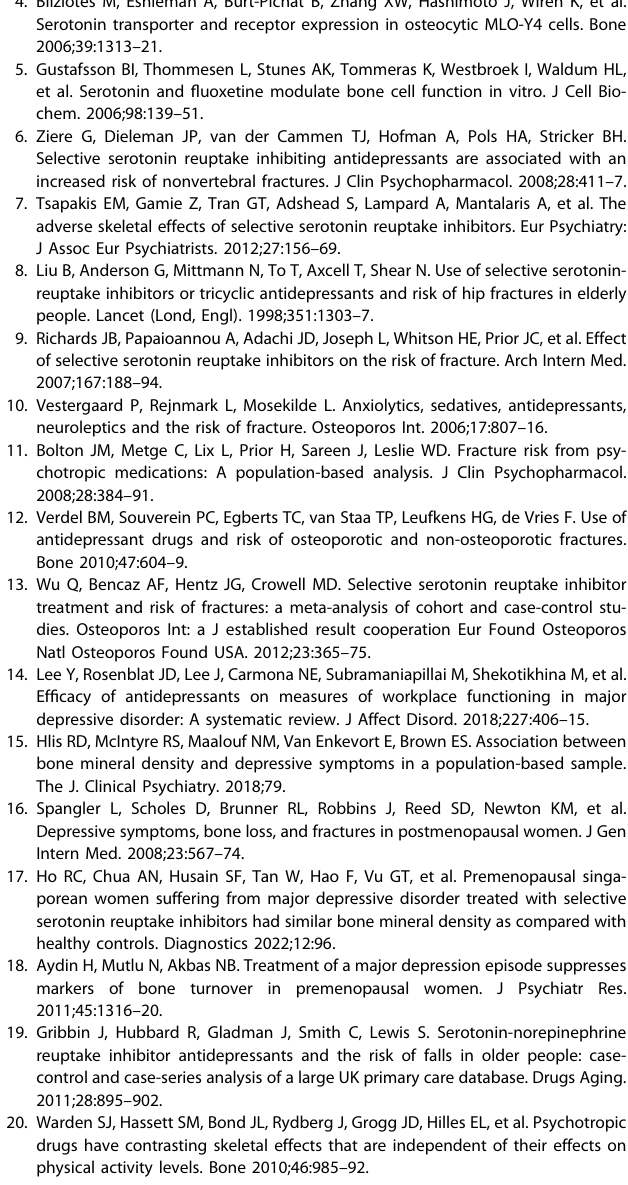
midshaft thickness, osteoblast per bone area and bending strength in rats without exposure to CMS. Under the CMS, both CMS + fl uoxetine and CMS + placebo showed the deterioration of bone structure, such as increase in trabecular separation, decrease in trabecular number and higher resorption para- meter. There were no statistical signi fi cance differences in bone microarchitecture in rats exposed to fl uoxetine and control condition without stress. Previous reports describing the association between fl uoxetine and low BMD in humans suffering from depression were susceptible to confounding by other factors, such as age, ethnicity, variation in diet and nutrition, smoking, substance abuse and concurrent use of other medications.